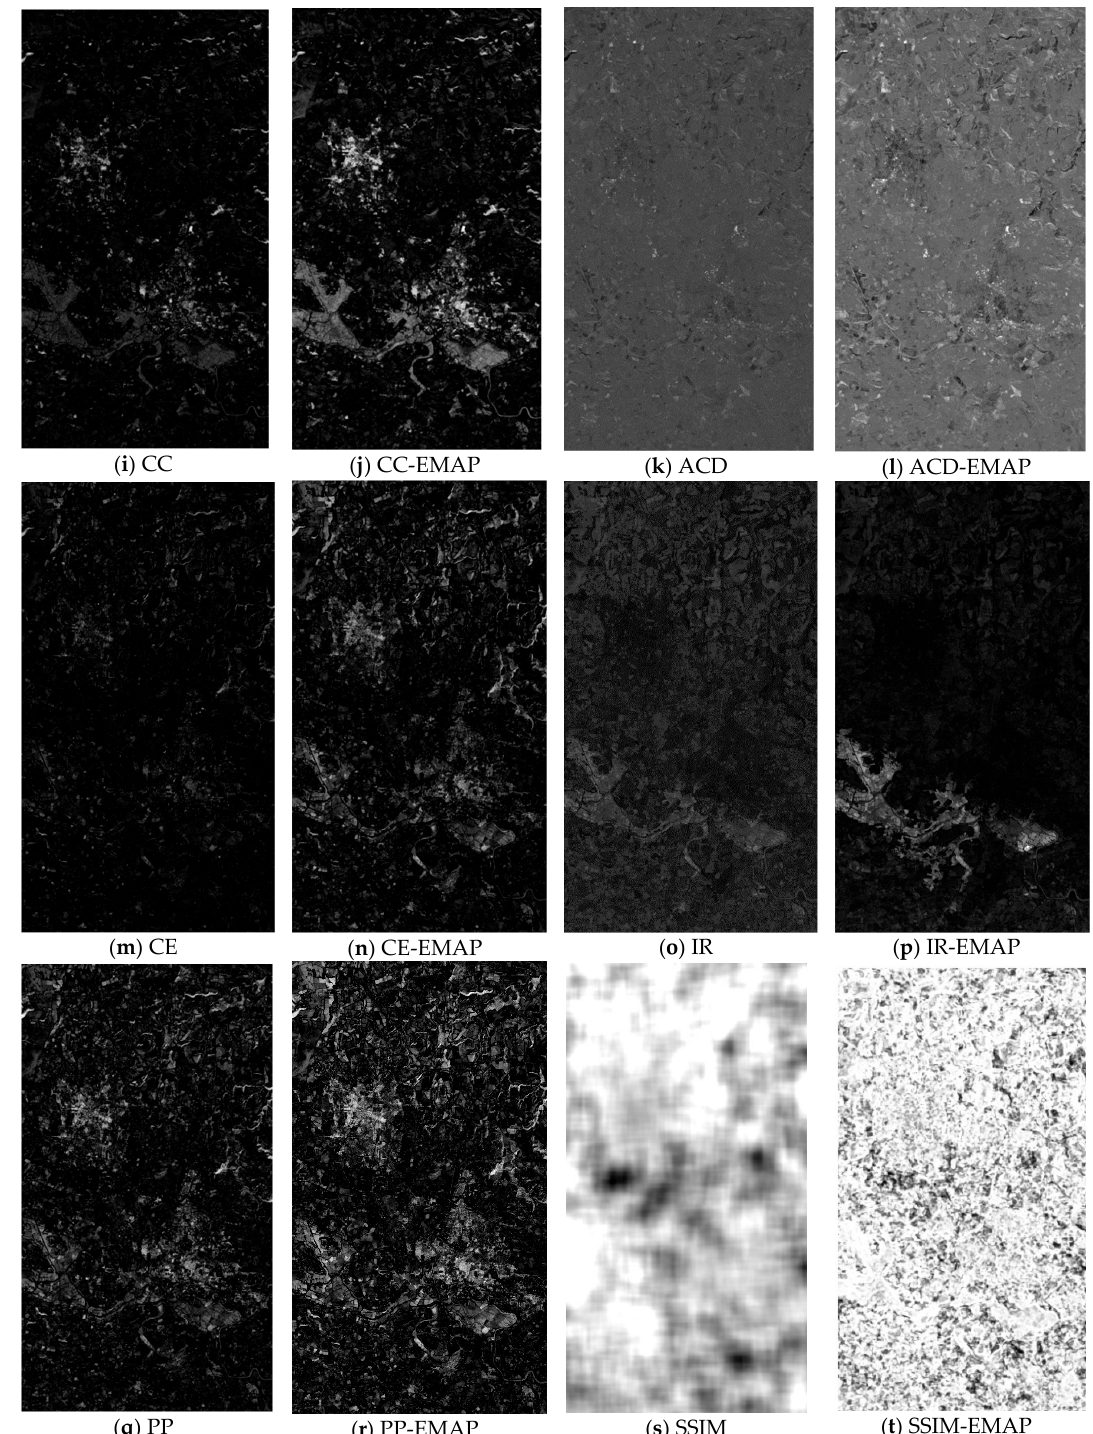
Figure 13. Ground truth and change detection score image for the best performing methods (Image Pair-3).